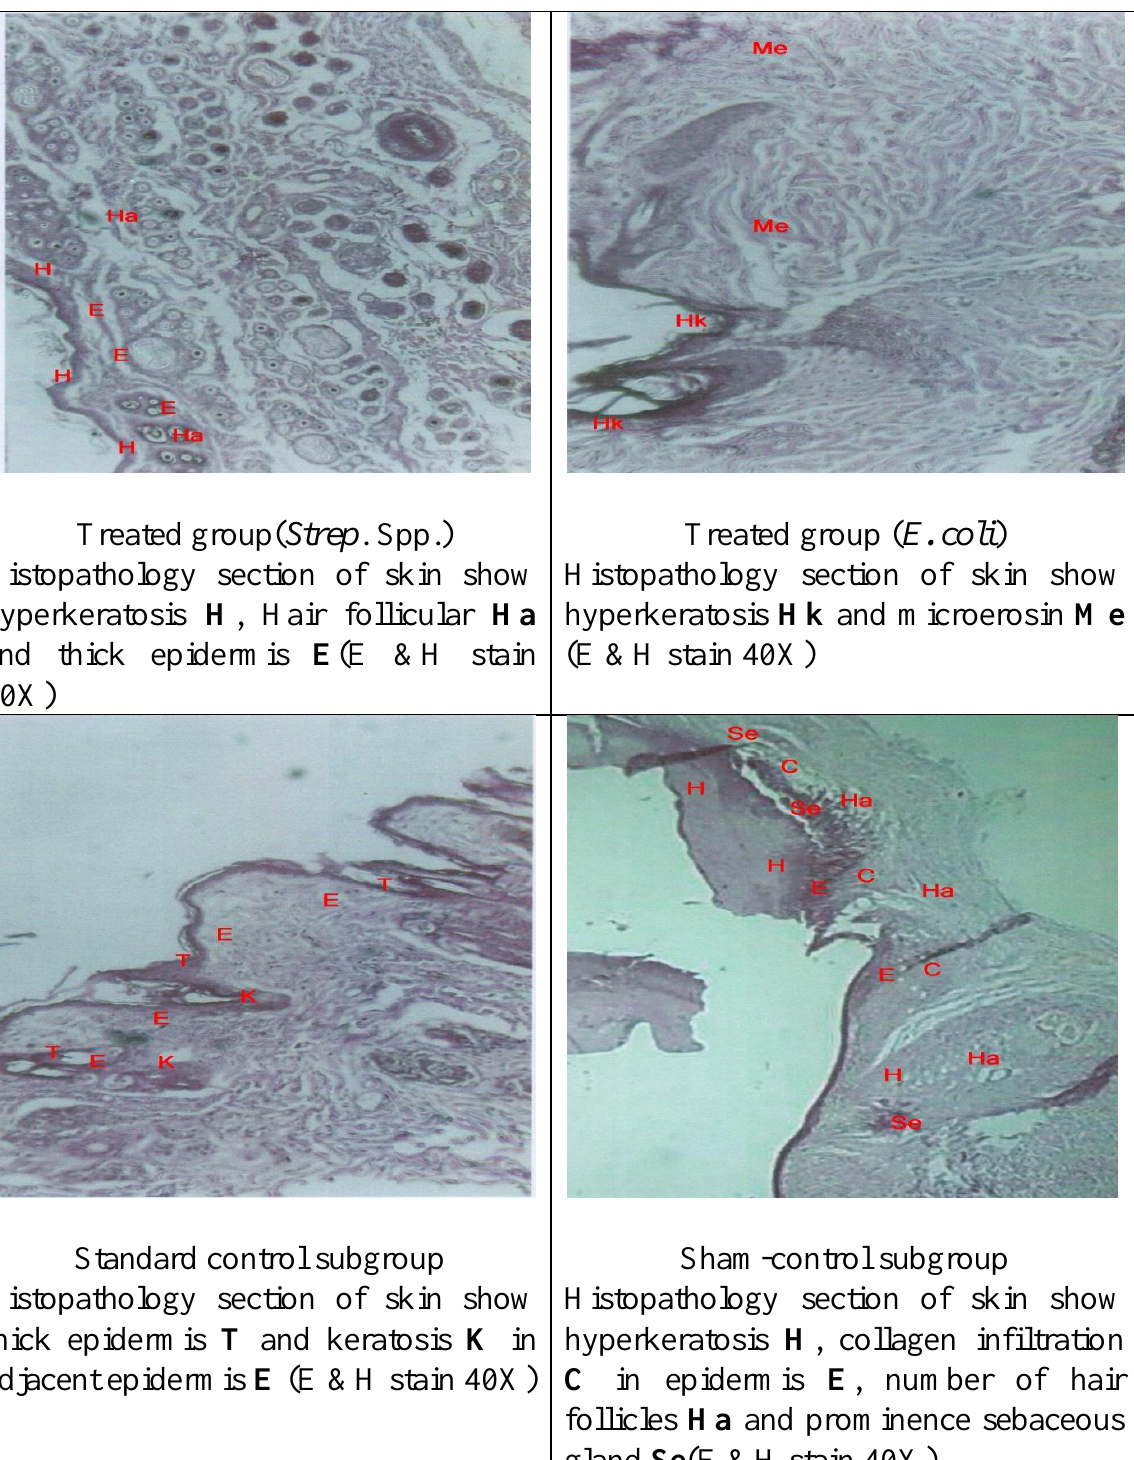
Figure (7) Histopathology section of animals group after (9 ) days of surgery